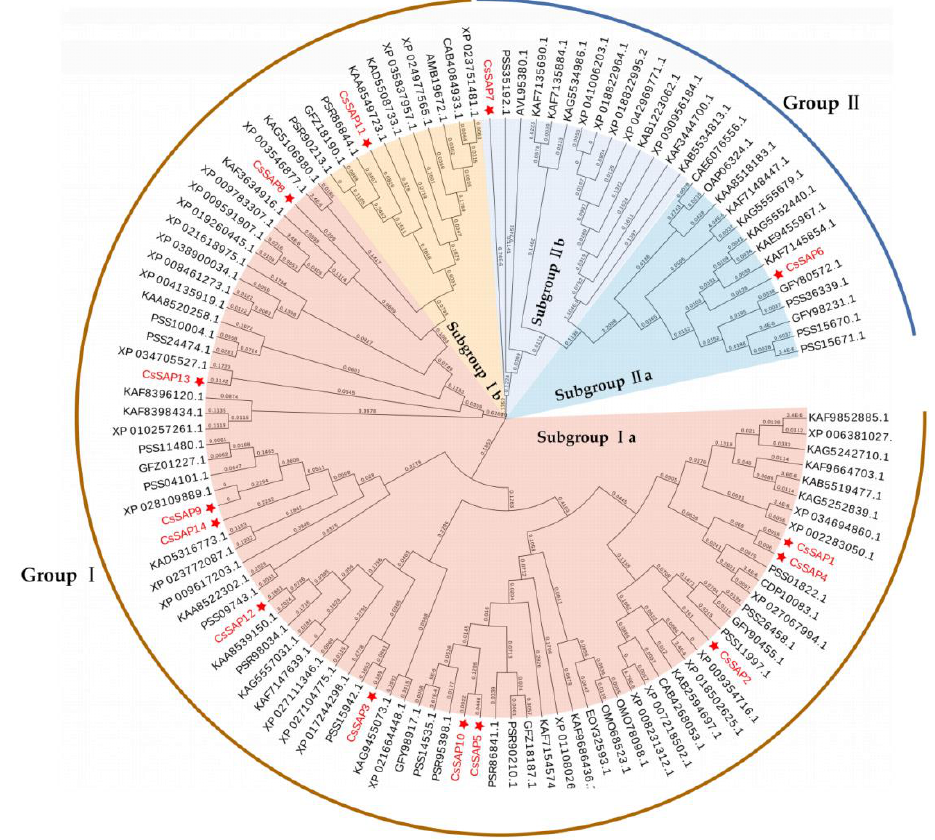
Figure 4. Phylogenetic analysis of 118 SAPs from 20 species of plants. The unrooted NJ tree was constructed using the full-length amino acid sequences. Ia, Ib, IIa, IIb indicates four subgroups. 14 CsSAPs in tea were showed in red and plus stars.